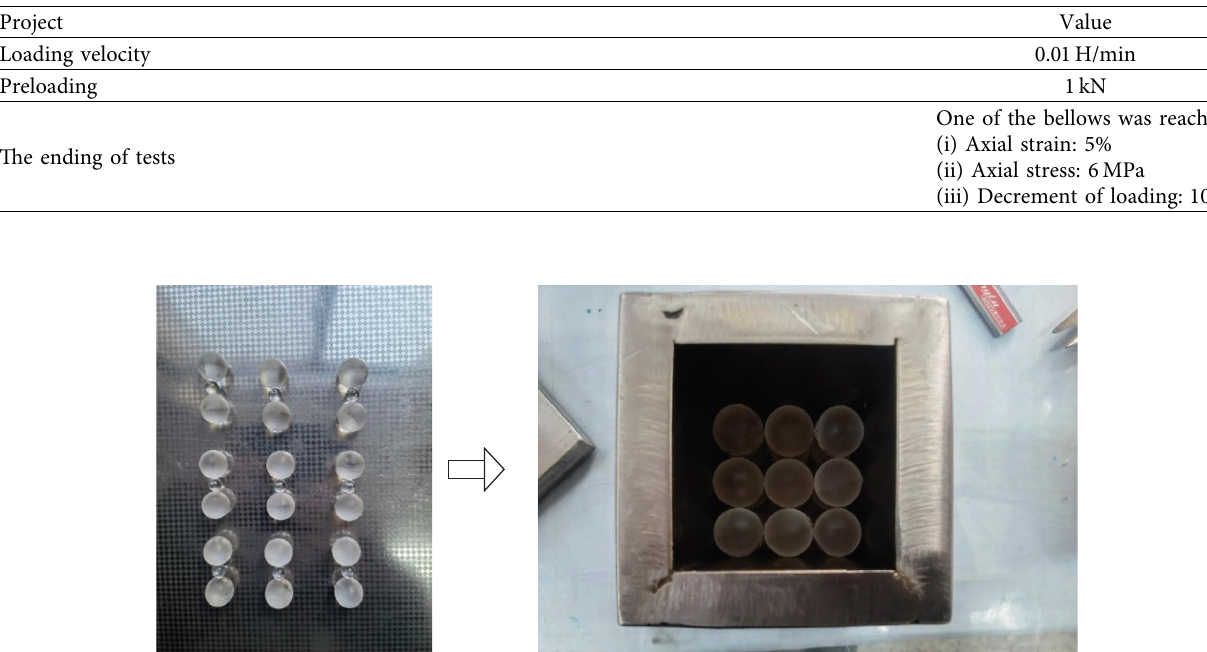
Table 5: Experimental details.